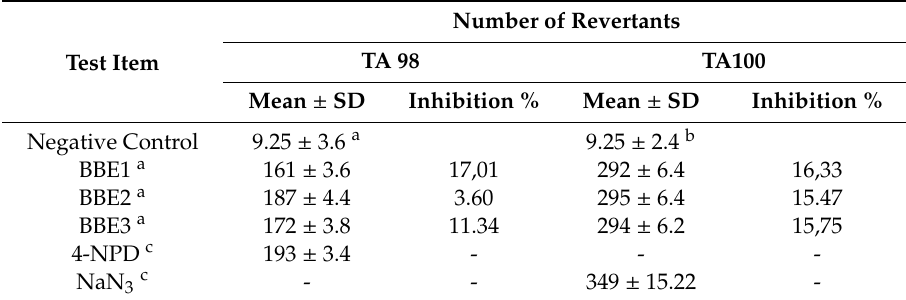
Table 8. Antimutagen properties of beech bark extracts (5 mg / plate) on S. typhimurium TA98 and TA100 bacterial strains.